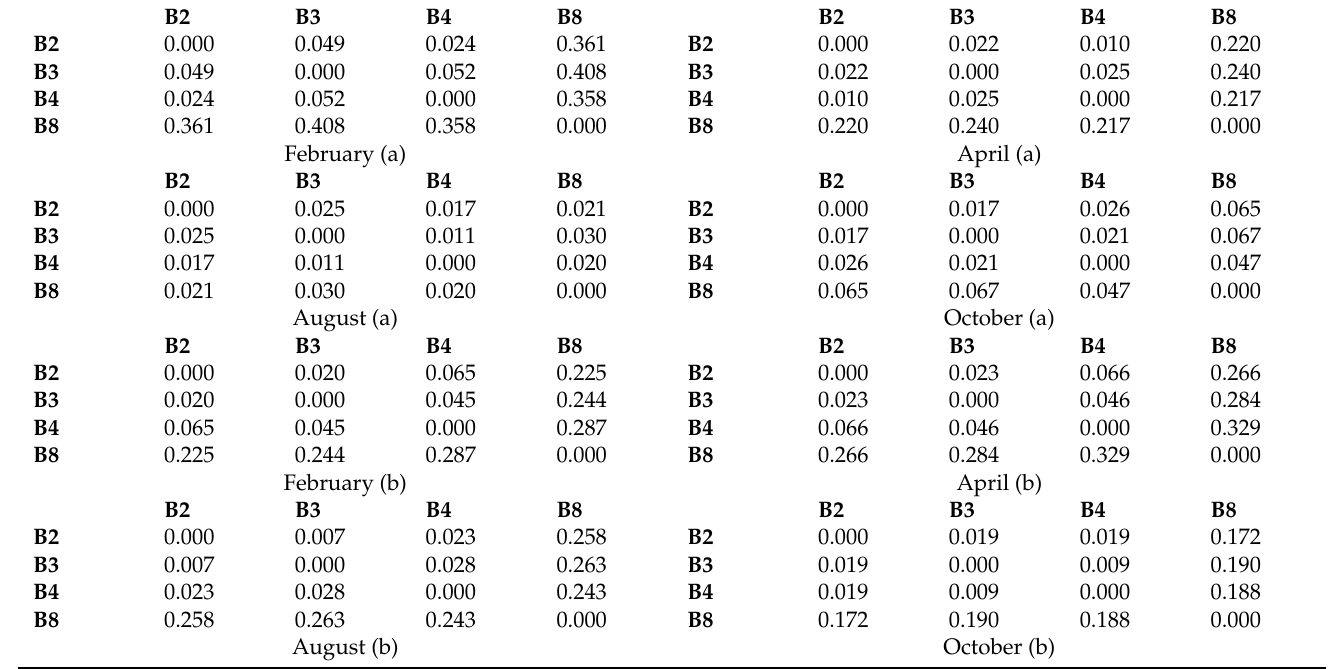
Table 3. Euclidean distance using Sentinel-2; (a): Tunisian study areas, (b): Greek study areas.